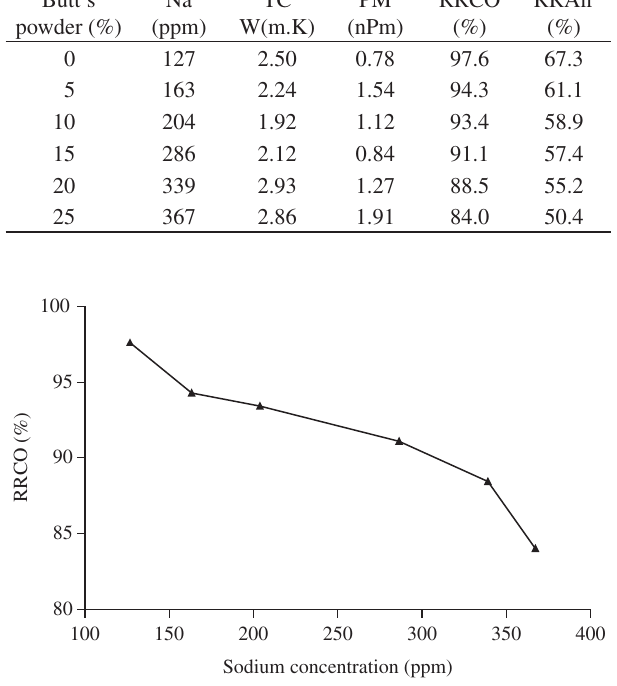
Figure 1. RRCO (%) changes as a function of the sodium concentration